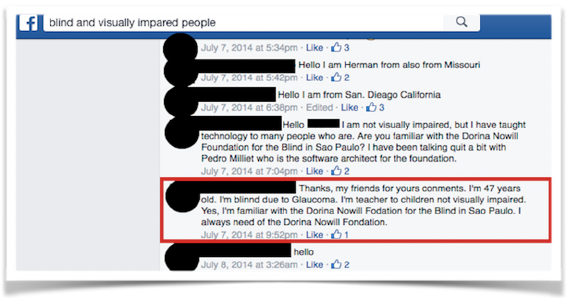
Figure 3. Student A thanking replies. Retrieved from [44] with permission.